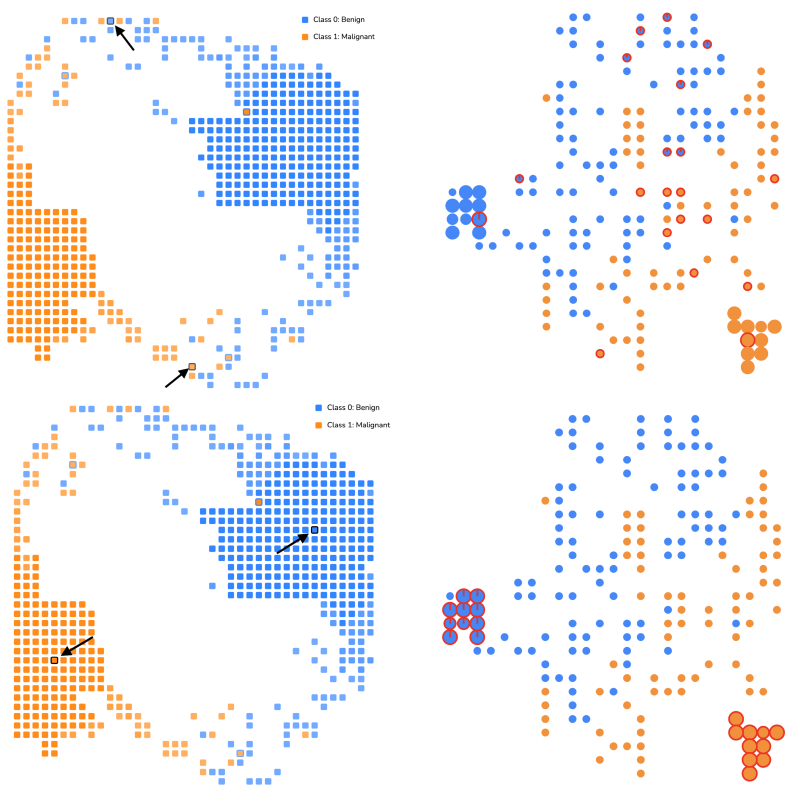
Figure 6. ( Top ) Left: Instance View where instances selected are marked by an arrow. These instances are not clearly separated, and hence Karen wants to investigate if they use the rules from the center part in Forest View. Right: Forest View shows the used decision paths highlighted in red. The majority of the rules belong to the center part, which has all the low-coverage rules. ( Bottom ) Left: Instance View with two perfectly classified instances selected. Right: These instances use high-coverage decision paths from the two blue and orange